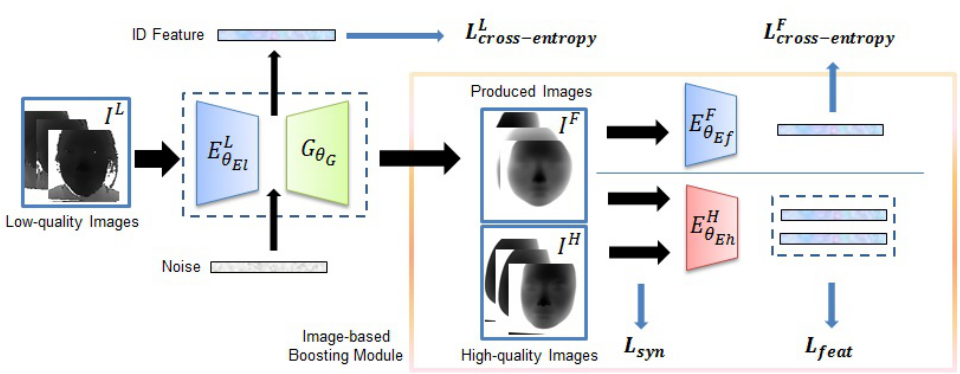
Figure 5. The workflow for image-based strategy. The blue extractors and green generator are needed to be trained and red extractor has been pretrained. The feature represented by ID Feature is finally used for matching. Although the all losses are shown in figure, in different specific methods, the parts of them are used, and details are shown in Section